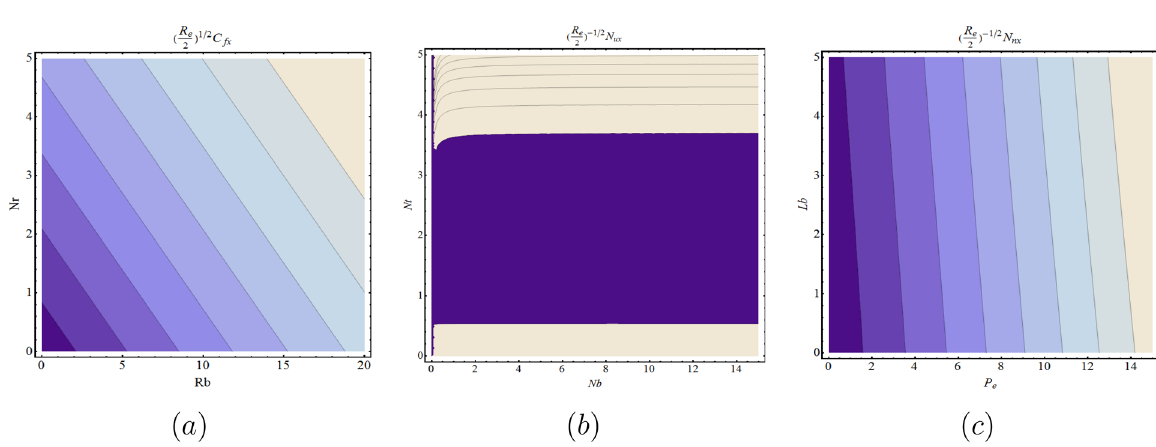
Figure 3. Contour graphs for ( a ) SFC, ( b ) LNN, ( c ) LDMM with R b , Nb , P e with various values of Nr , Nt and P e , respectively.